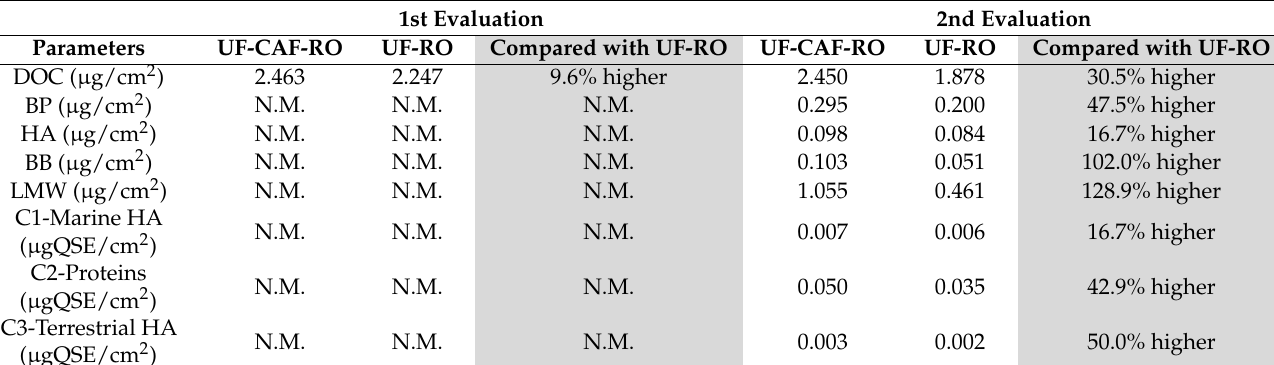
Table 2. Characterization of dissolved organic components on fouled RO membranes.